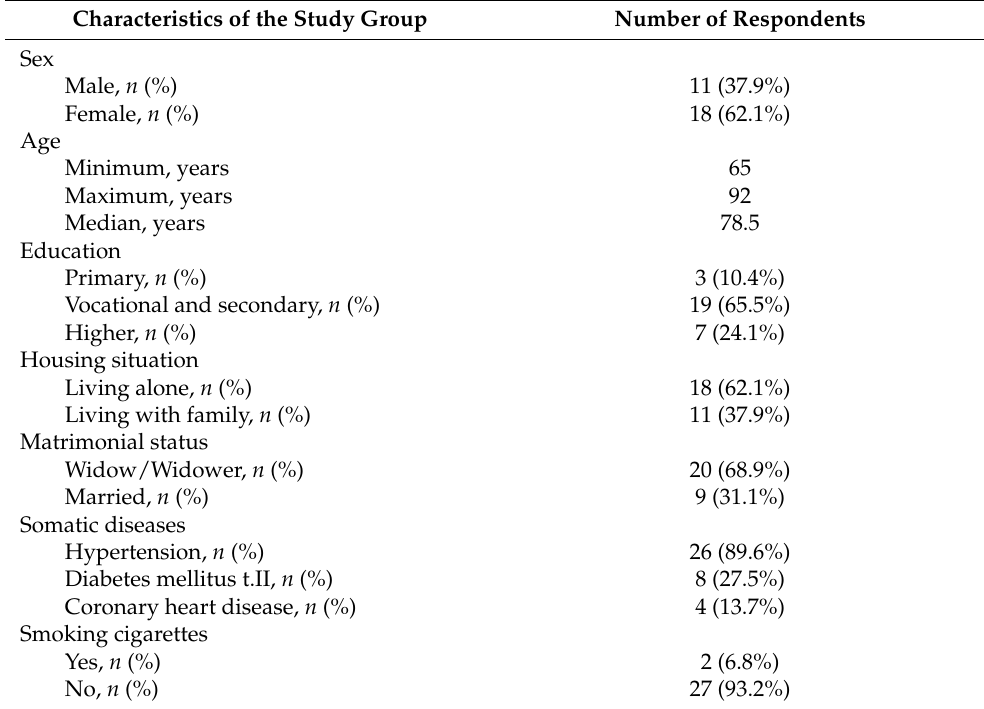
Table 1. Sociodemographic data relating to the study group. Characteristics of the Study